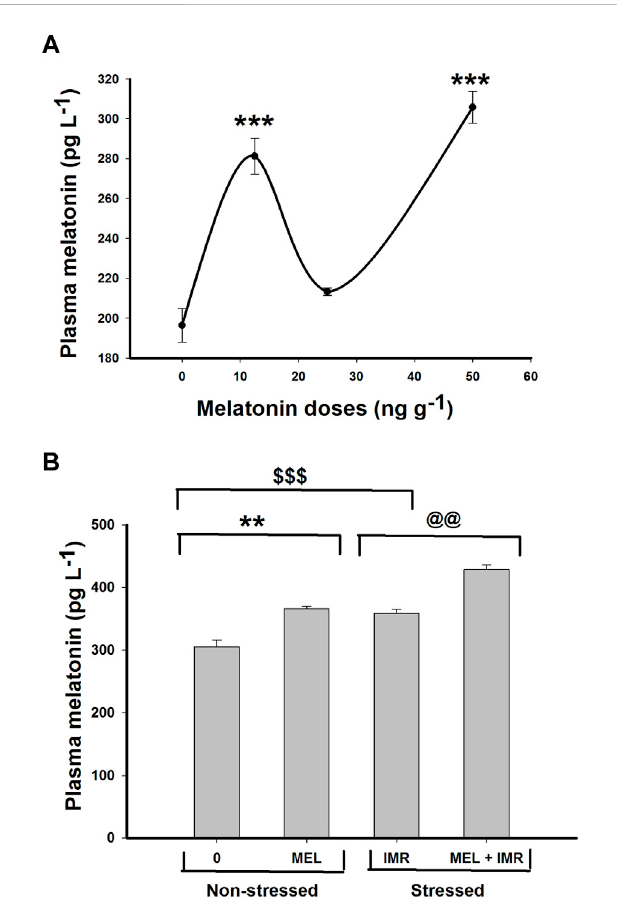
FIGURE 1 In vivo action of melatonin treatment for 30 min on plasma melatonin concentration in non-stressed or immersion-stressed air- breathing fi sh. (A) shows dose-responsive action of melatonin (MEL; 12.5, 25 and 50 ng g − 1 ) and (B) represents the action of melatonin (MEL; 50 ng g − 1 ) for 30 min in immersion-stressed fi sh (IMR). Each plot represents mean ±